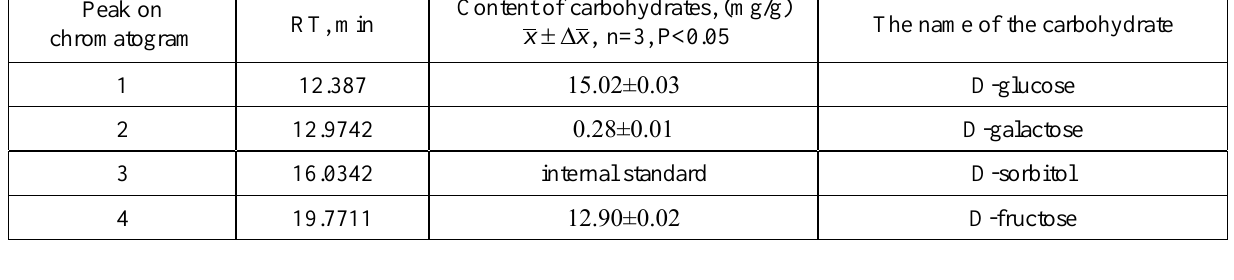
The results of free carbohydrates determination in Agrimonia eupatoria L. herb.